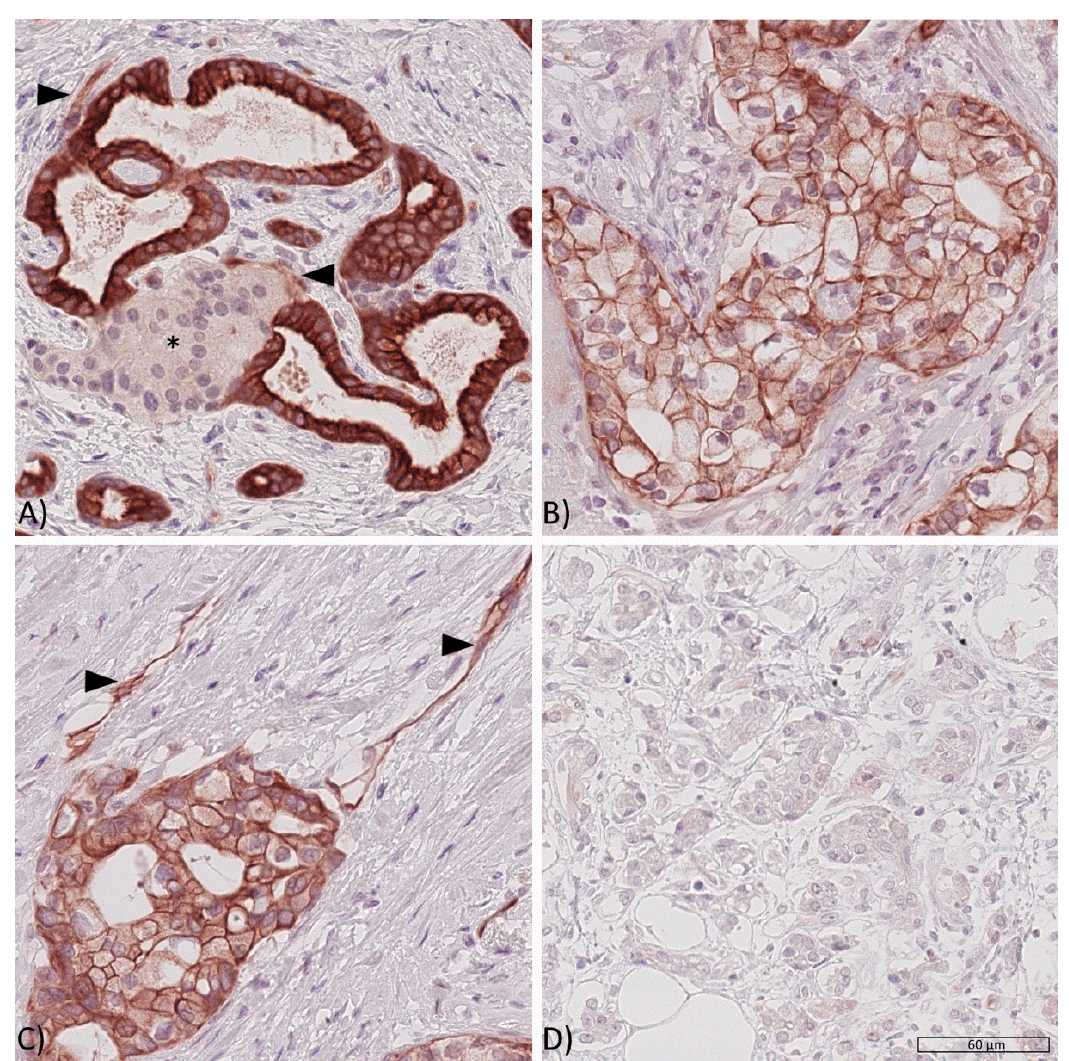
Figure 1. Expression of the insulin receptor in PDAC tissues. Representative PDAC tissue samples showing ( A ) high cytoplasmic (cCC-IR 2+), high membranous (mCC-IR 2+) and low vascular (arrow heads, VIR 1+) insulin receptor expression with pancreatic cancer cells surrounding a pancreatic islet (asterisk*), ( B ) low cytoplasmatic (cCC-IR 1+) and low (mCC-IR 1+) as well as high membranous (mCC-IR 2+) insulin receptor expression, ( C ) low (mCC-IR 1+) as well as high (mCC-IR 2+) membranous, weak cytoplasmic (cCC-IR 1+) and strong vascular (VIR 2+, arrowheads) insulin receptor expression and ( D ) absent tumoral or vascular insulin receptor expression. Anti-insulin receptor immunostaining, hematoxylin counterstaining. Original magnification A-D: 400×.